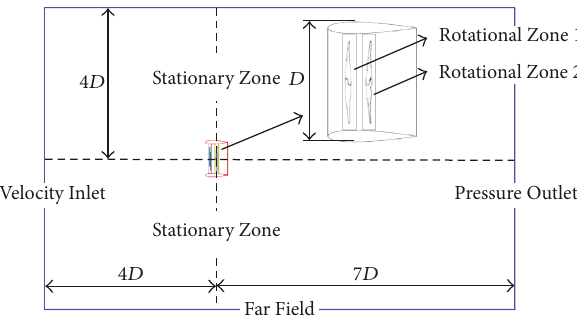
Figure 4: Computational domains of ducted coaxial rotors.